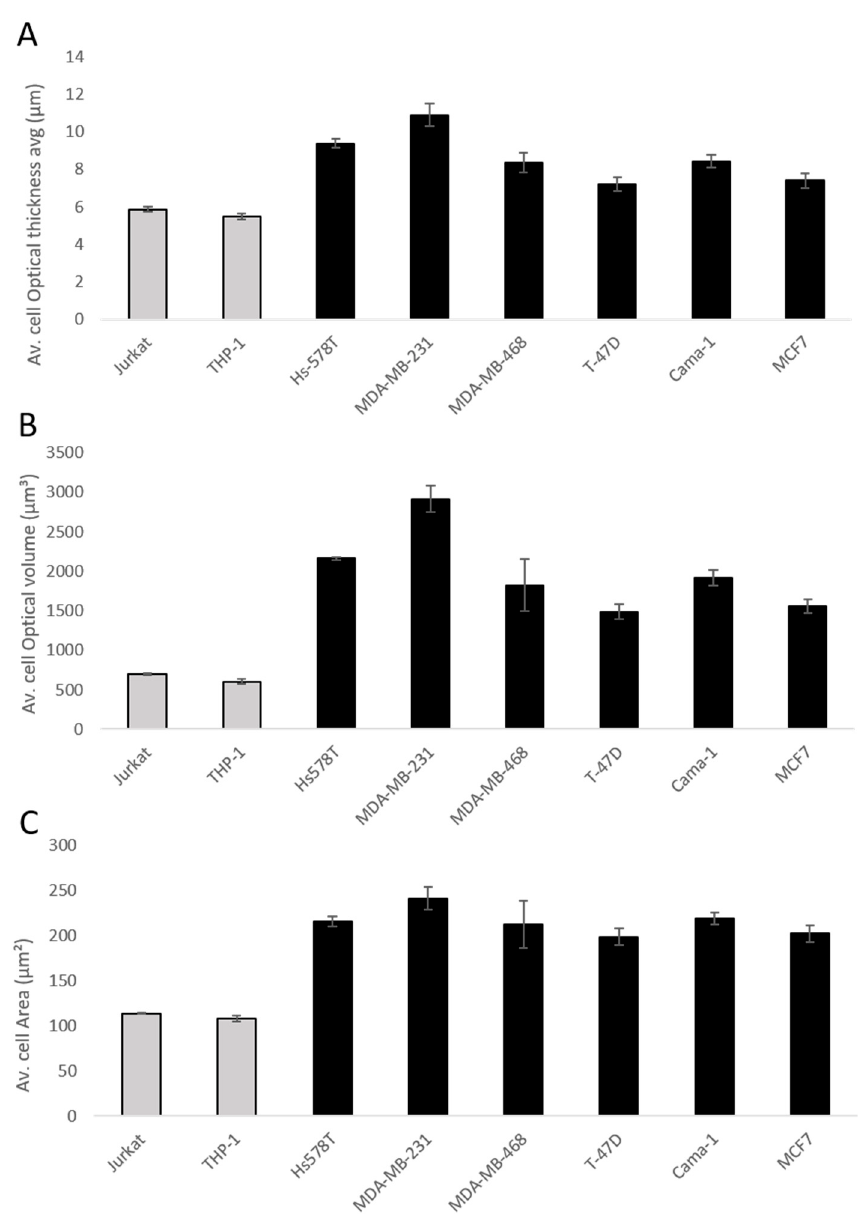
Figure 3. Diagrams presenting the average cell area ( A ), average optical volume ( B ) and average cell thickness ( C ) for Jurkat, THP-1 and six breast cancer cell lines. The calculations were based on at least 10 images / sample. All results comparing THP-1 and Jurkat with the breast cancer cells were significant with p < 0.005.